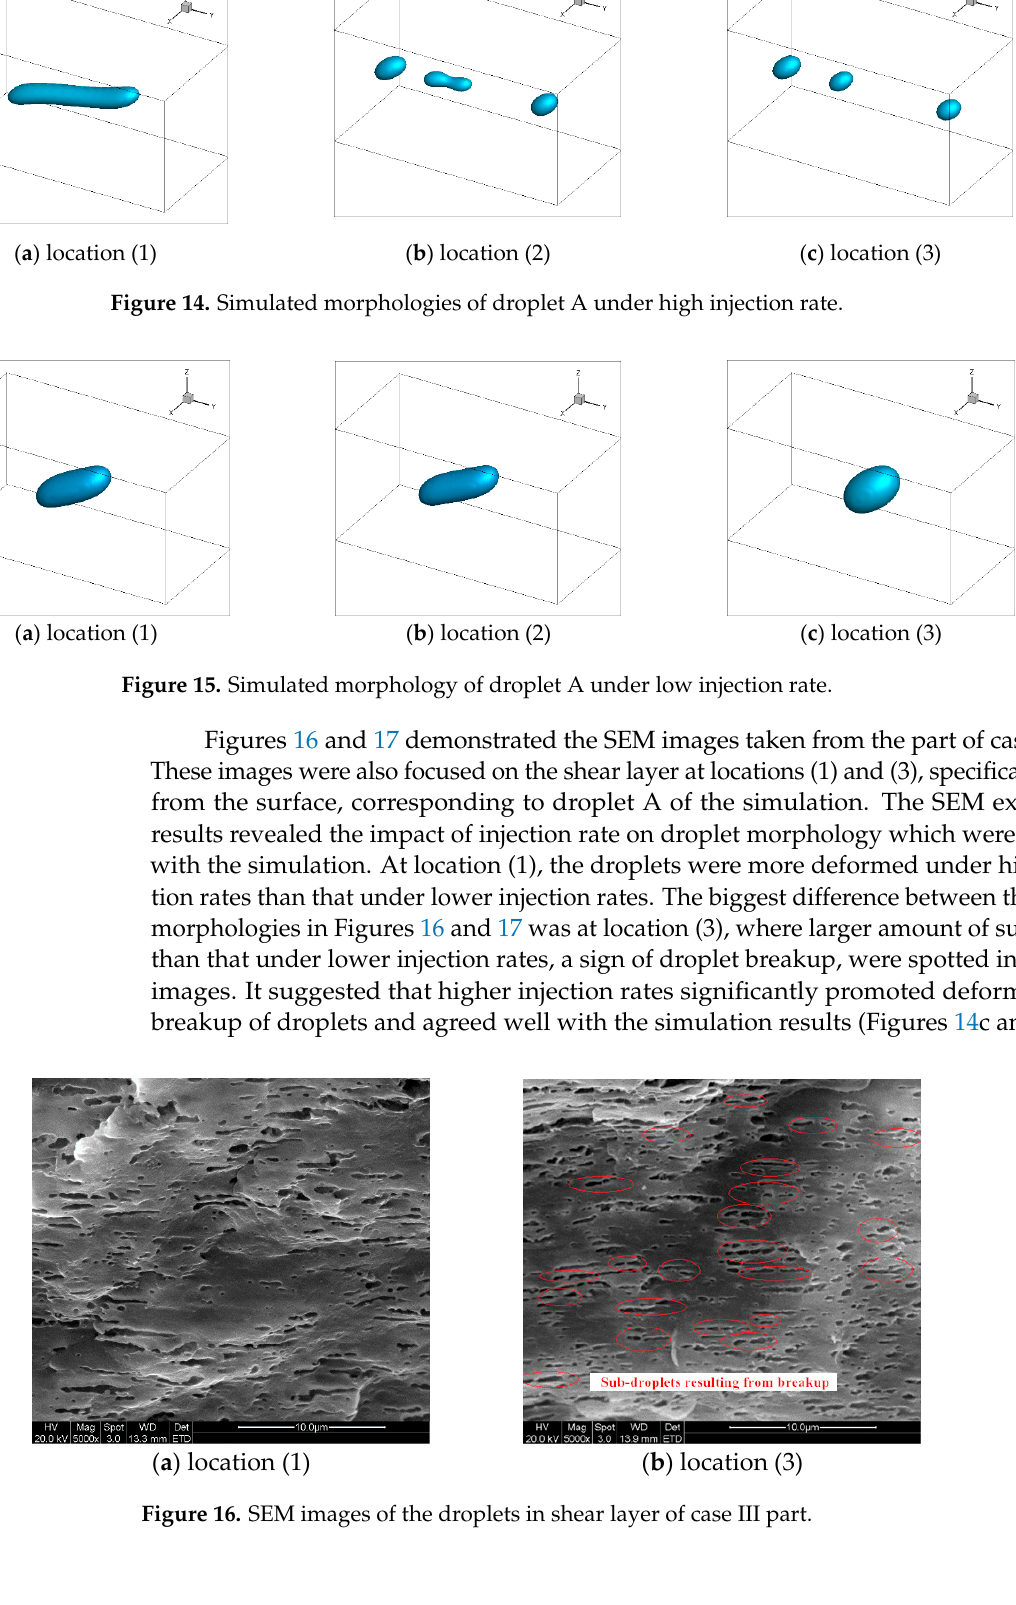
( b ) location (3) Figure 17. SEM images of the droplets in shear layer of case I part. Figure 18 illustrated the statistics of the droplets morphologies on Figures 16 and 17. Here the droplets were assumed axisymmetric and ellipsoidal while the semi-major and semi-minor axes of the droplets, L and W , were measured on the SEM images using the image analysis program Nano measurer. Then the equivalent radius R and deformability D of the droplets were given by: